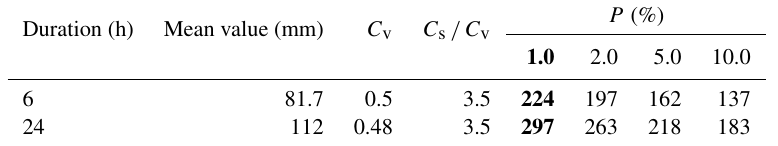
Table 3. Rainfall parameters ( C s : coefficient of skewness; C v : coefficient of variation; P: flood recurrence period). Bold font denotes the values used in the simulation.